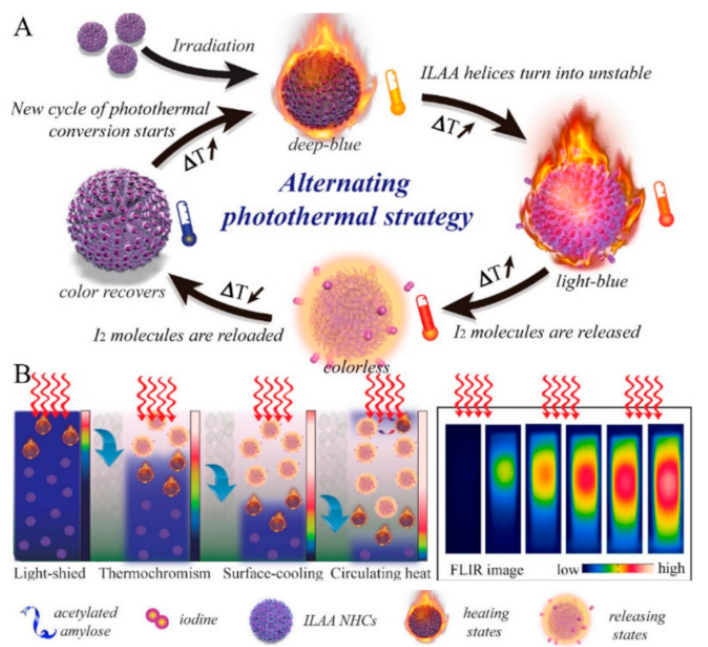
Figure 7. Photothermal strategy based on ILAA NHCs. ( A ) Alternating photothermal cycle based on reversible thermochromic ILAA NHCs for temperature self-regulation. ( B ) The reversible thermochromism-induced enhanced efficient photothermal depth. Optimal ILAA NHCs demon- strate reversible thermochromism in which the color disappears and repeatedly recovers at the proper temperature concerning the I 2 release and reload on the nanoparticles. Adapted with permis- sion from